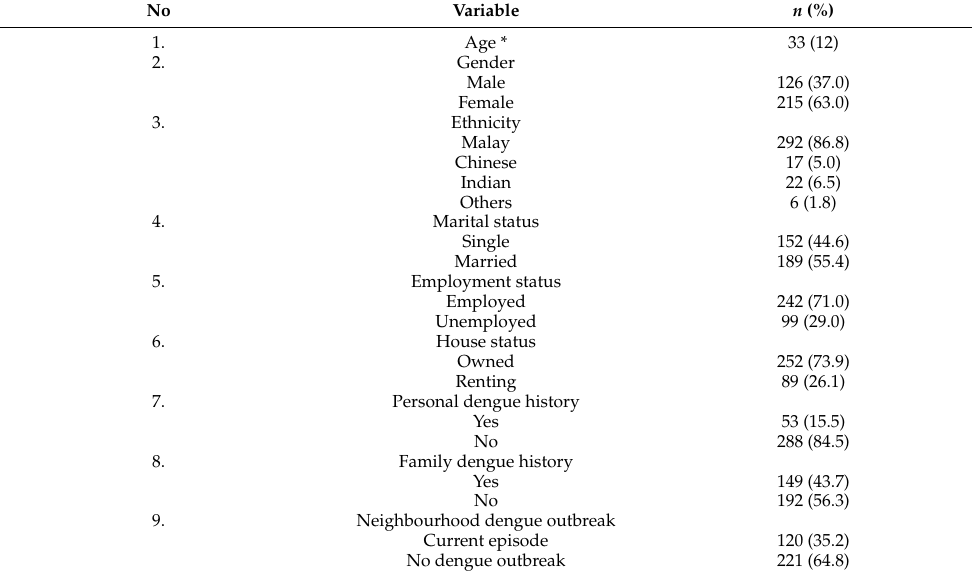
Table 2. Characteristics of respondents ( N =